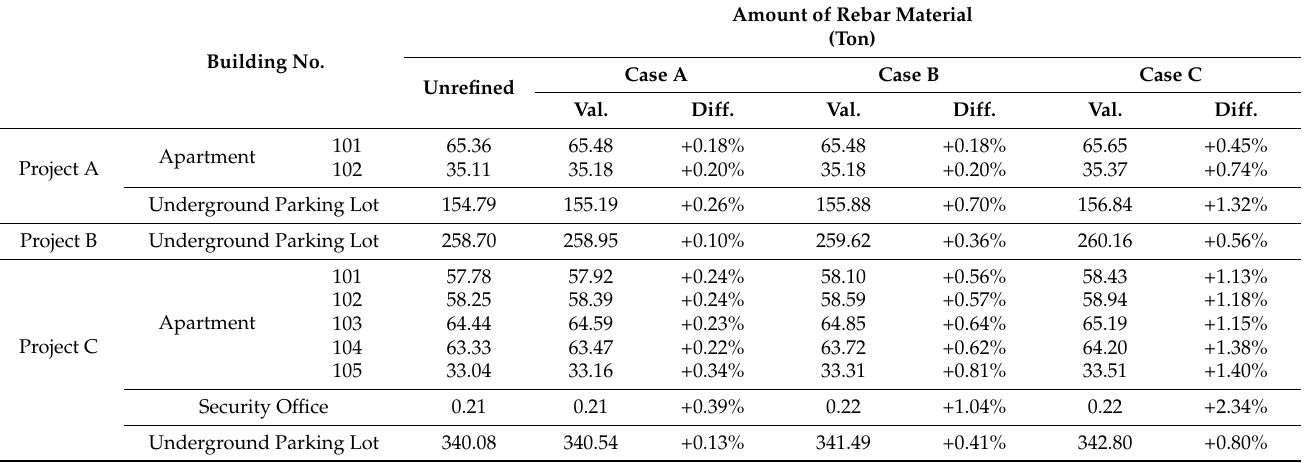
Table A10. Amounts of Rebar Materials for Basement Members and Differentials by